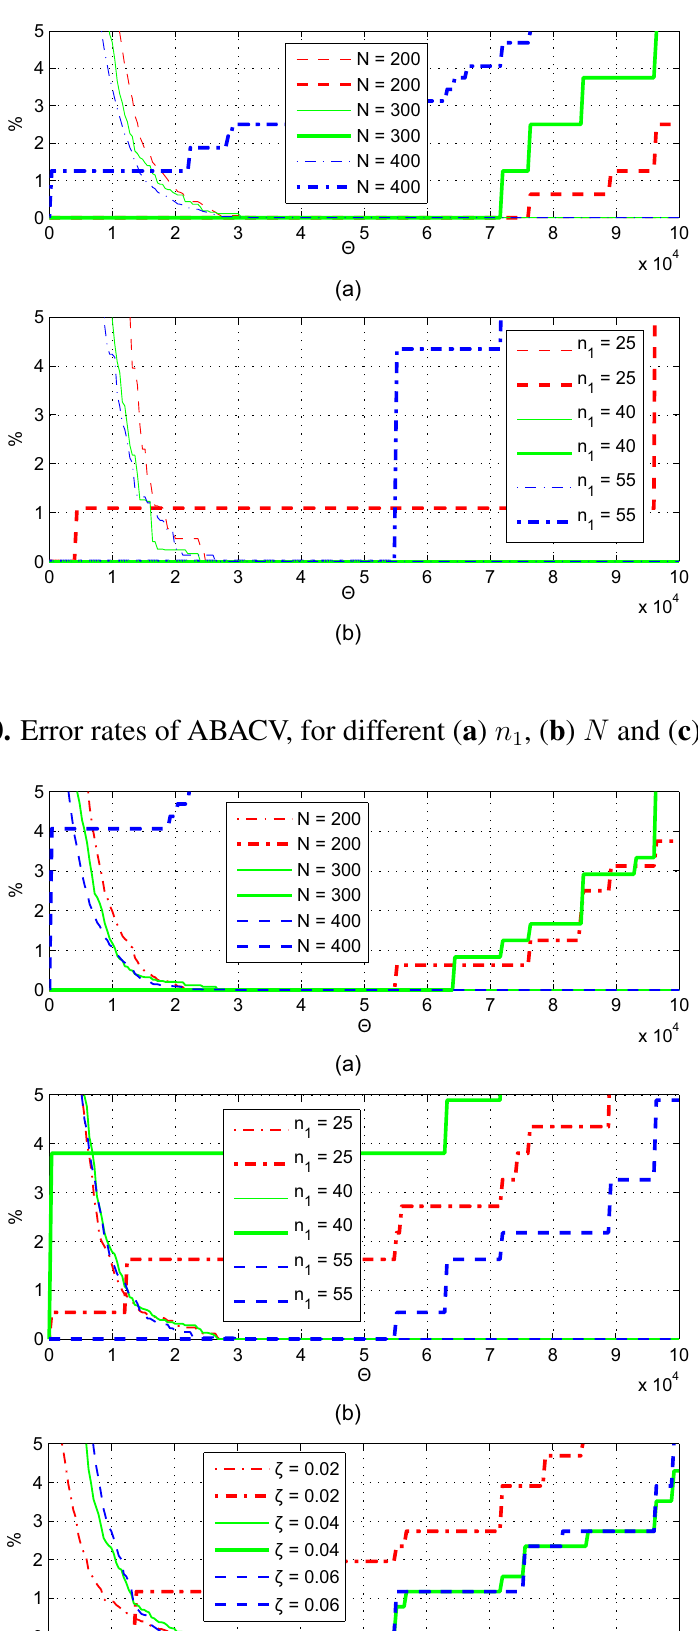
Figure 9. Error rates of BACV, for different ( a ) n